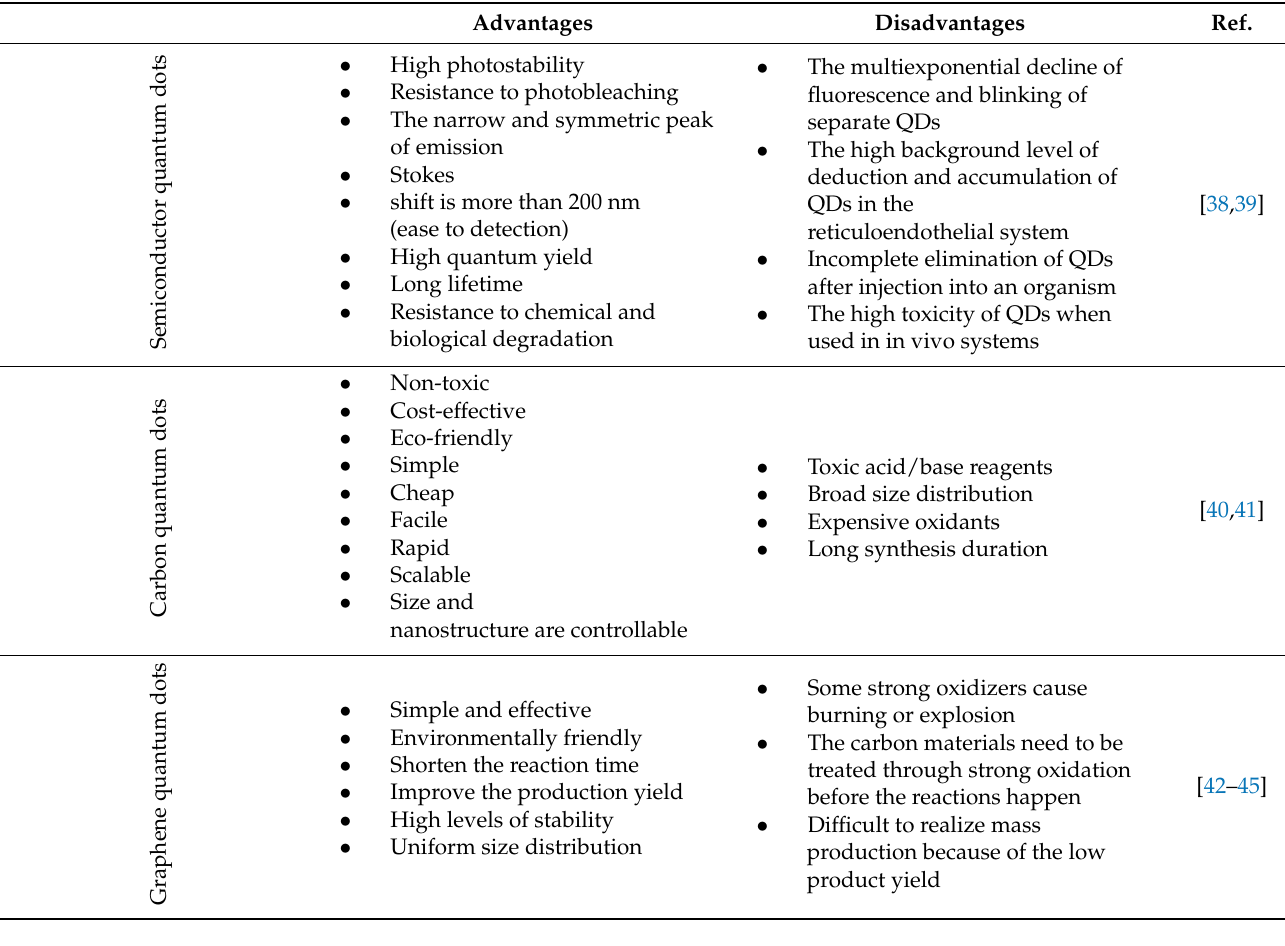
Table 2. Advantages and disadvantages of semiconductor, carbon, and graphene quantum dots. Advantages Disadvantages